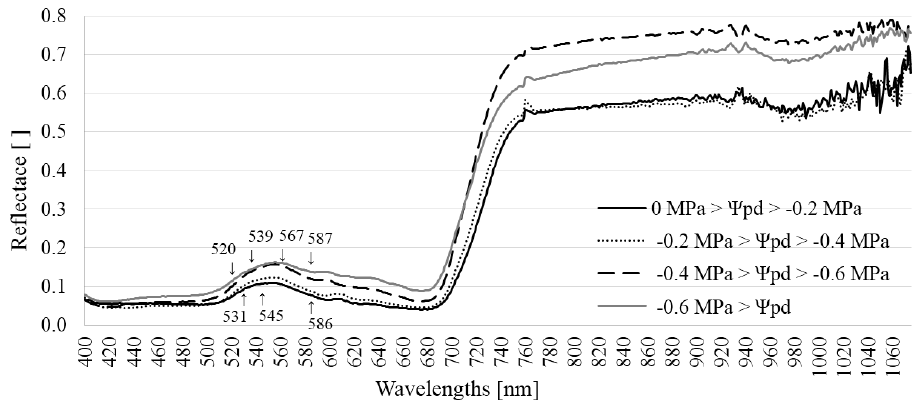
Figure 4. Reflectance spectra signatures obtained for the different water deficit conditions defined by Carbonneau [47] for a vineyard. The vertical arrows represent the wavelengths selected for the optimal vegetation indices.